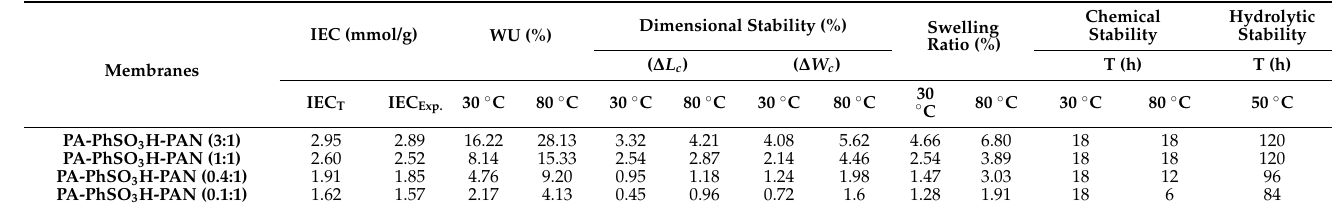
Table 2. Ion exchange capacity (IEC), water uptake (WU), dimensional stability, swelling ratios, and chemical stability and hydrolytic stability of PA-PhSO 3 H-PAN with different ratios. IEC (mmol/g) WU (%) Dimensional Stability (%) Swelling Membranes